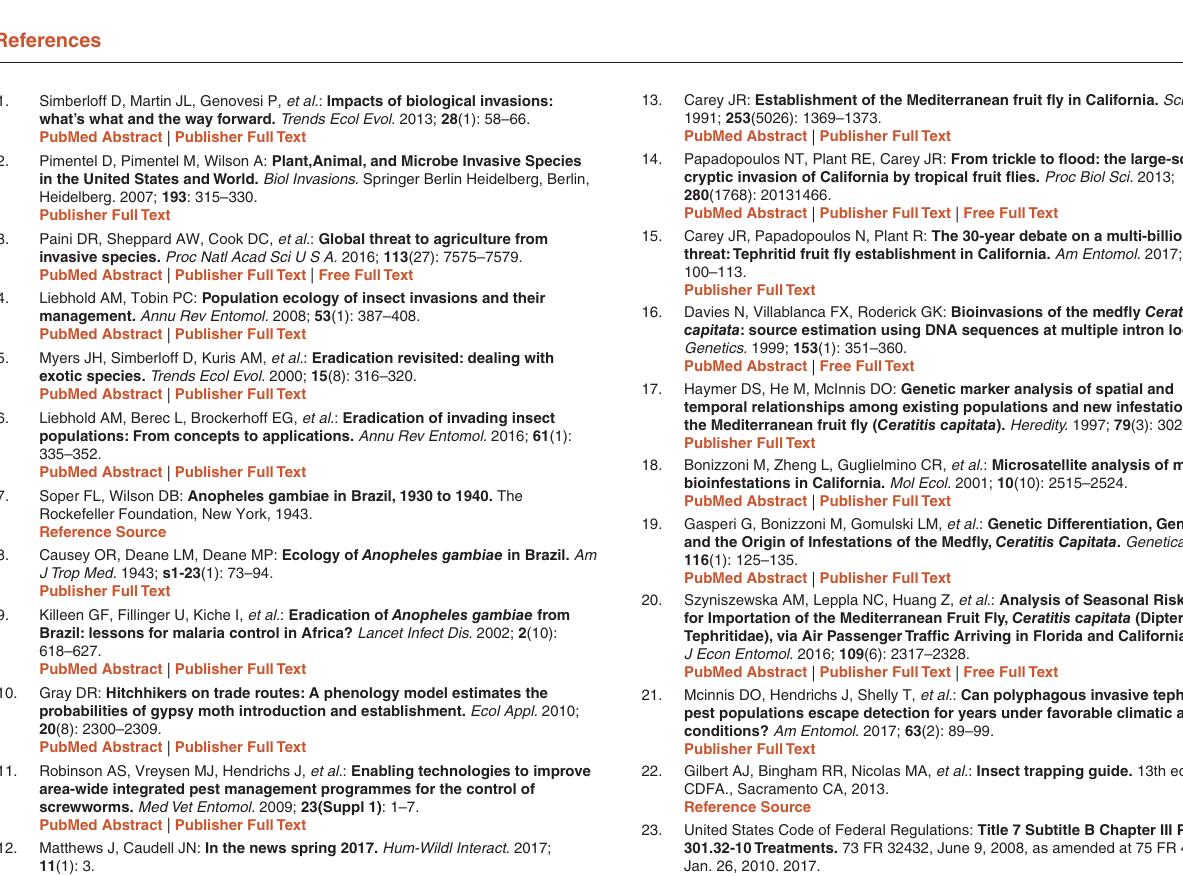
Figure S1: Daily normal of hourly temperatures. Hourly temperature data aggregated by day of year. Click here to access the data. Figure S2: Degree day based PQL supernorm. Single sine degree day based predicted quarantine lengths aggregated by day of year. Click here to access the data. Figure S3: MED-FOES PQL based supernorm. MED-FOES based predicted quarantine lengths aggregated by day of year. Click here to access the data. Figure S4: Difference in PQL at nearby sites (LA basin example). The difference in PQL values for the same start date (including year) between sites in the LA basin. For each date over the range of available data (1973 through 2015 for LAX-BUR and RIV-BUR, 1950 through 2015 for LAX-RIV), PQL values for each site are computed and the differences taken. The resulting differences are then aggregated by day-of-year. Lines show the median while the shaded region is the 25% to 75% quantile range for each day-of- year aggregation of differences. Click here to access the data. Table S1: MED-FOES parameters. Parameter values or Latin-Hypercube Sampling ranges used for running MED-FOES simulations. Click here to access the data. Table S2: Historical quarantines. Historical quarantines in California. Click here to access the